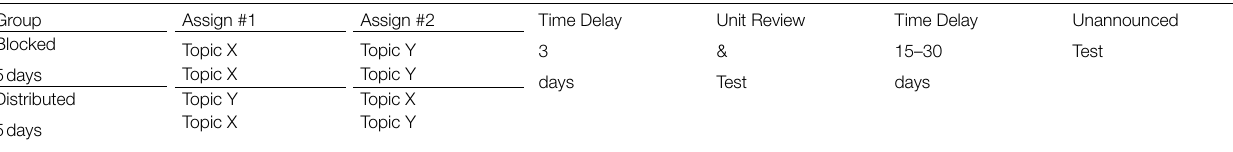
TABLE 1 | An experimental set up to compare blocked vs. distributed